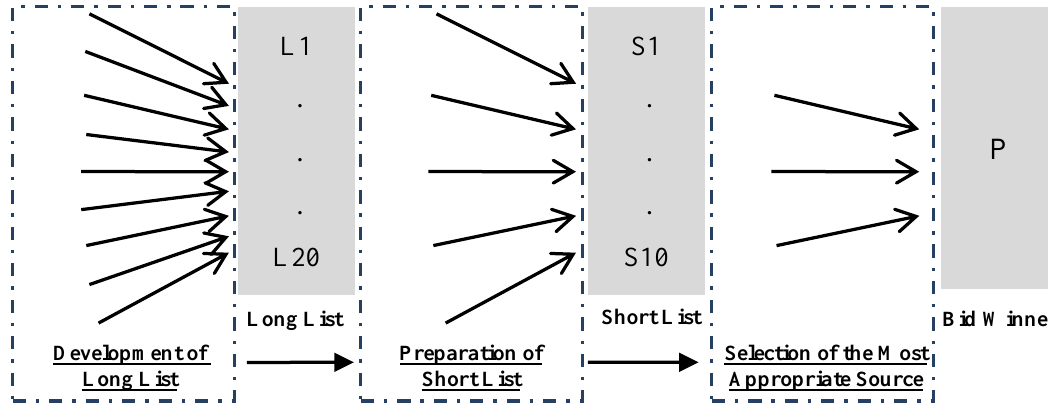
Figure 3. Hierarchal levels of source selection in the construction industry.